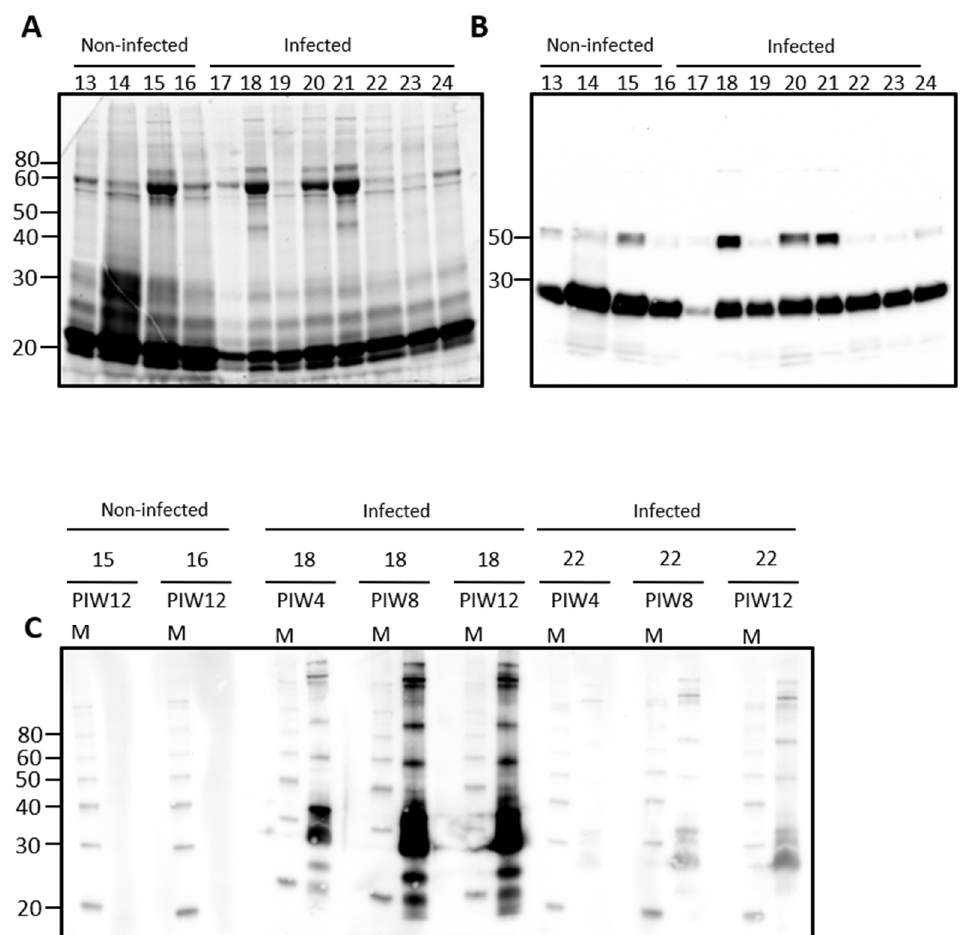
Figure 1. Representative total protein content ( A ) or IgG detection ( B ) in rat urine. Urine was collected from outbred male rats at post-infection week (PIW) four after inoculation by the intraperitoneal route. Urinary IgG specific for leptospires was demonstrated in infected rats by immunoblotting of leptospires ( C ) with urine collected at PIW 4, 8, and 12 in infected rats (numbered 17–24) compared to non-infected controls (numbered 13–16). Molecular mass markers (M) are indicated in kDa.